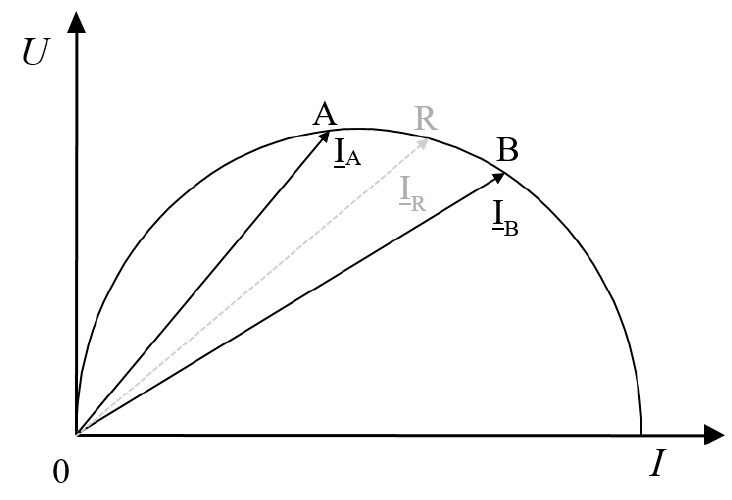
Figure 8. Circular chart of an arc device.